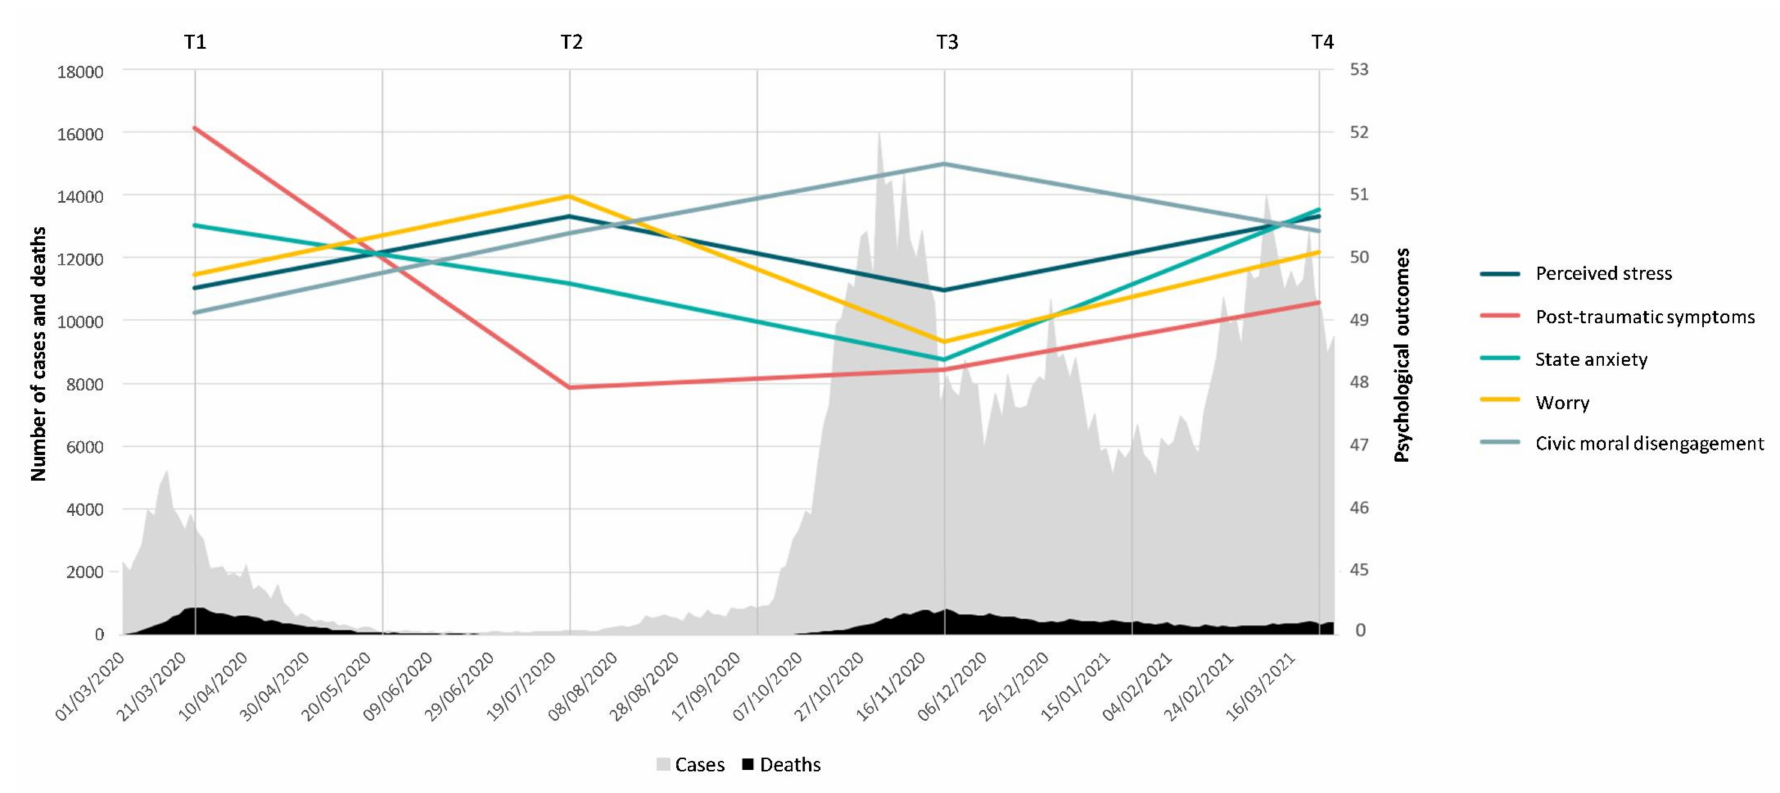
Figure 1. Trend of the perceived stress, post-traumatic symptoms, state anxiety, worry, and civic moral disengagement and cases and deaths during one year of COVID-19. Note: T1, March 2020; T2, August 2020; T3, November 2020; T4, March 2021; Cases = number of confirmed SARS-CoV-2 virus infections; Deaths = number of cases that have died. The data for number of cases and deaths were from the report of “Epicentro” [29]; when the number of deaths was < 5, it was approximated to zero in creating the chart. For the psychological outcomes, raw data were converted into t -scores to get better visibility in the